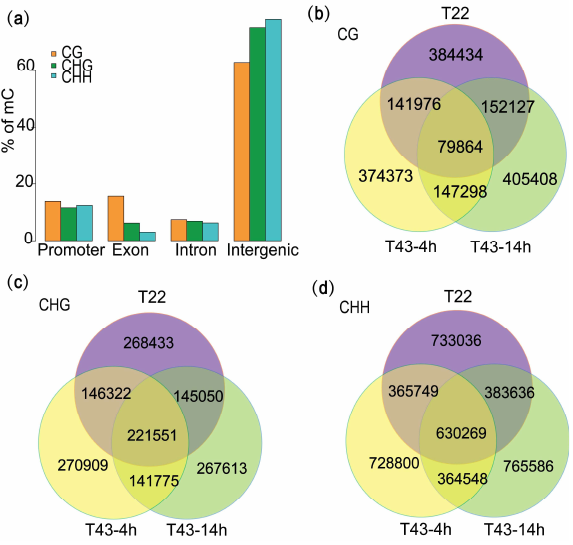
Figure 3. Distribution and changes of mCs under 22 °C and heat stress. ( a ) Percentage of mCs found in each genomic region; ( b – d ) comparison of mCs between T22, T43-4h and T43-14h for mCG, mCHG and mCHH sites, respectively.